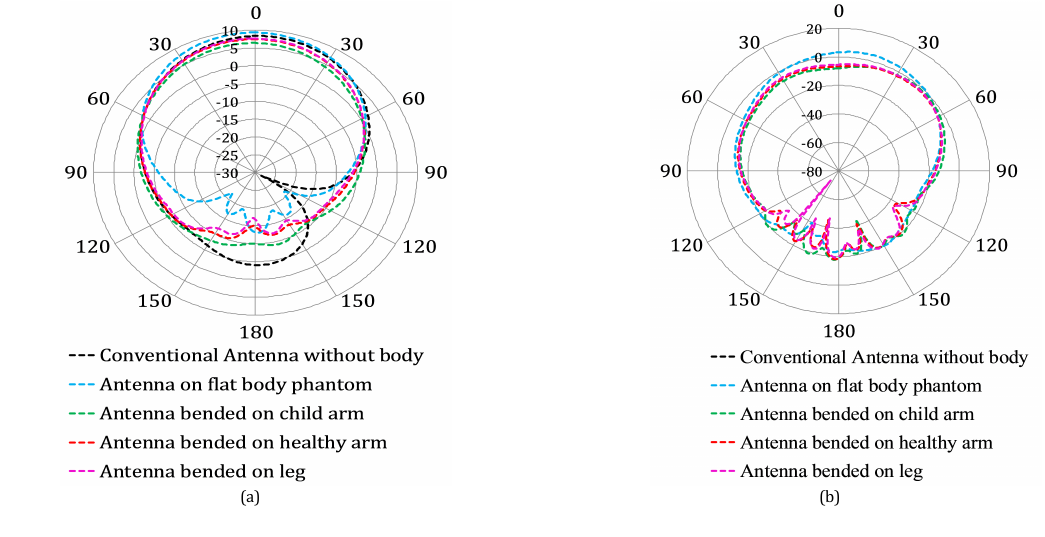
Figure 21. On-body directivity patterns at ( a ) 2.5 GHz and ( b ) 5.2 GHz.